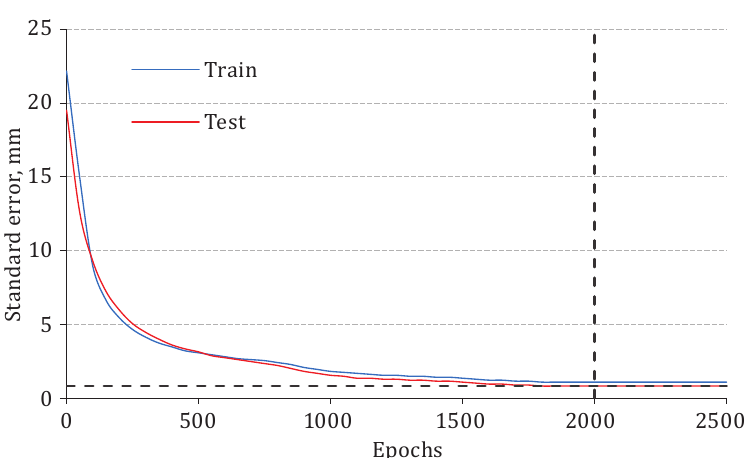
Figure 8. Rutting neural network performance